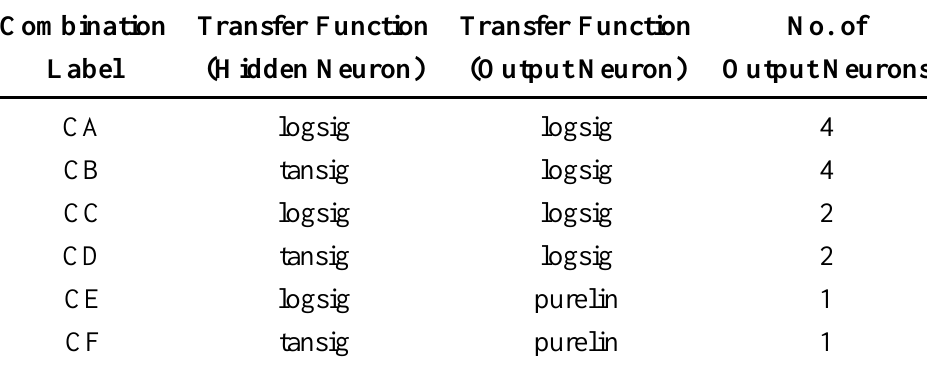
Table 1. Properties of each investigated MLP neural network.